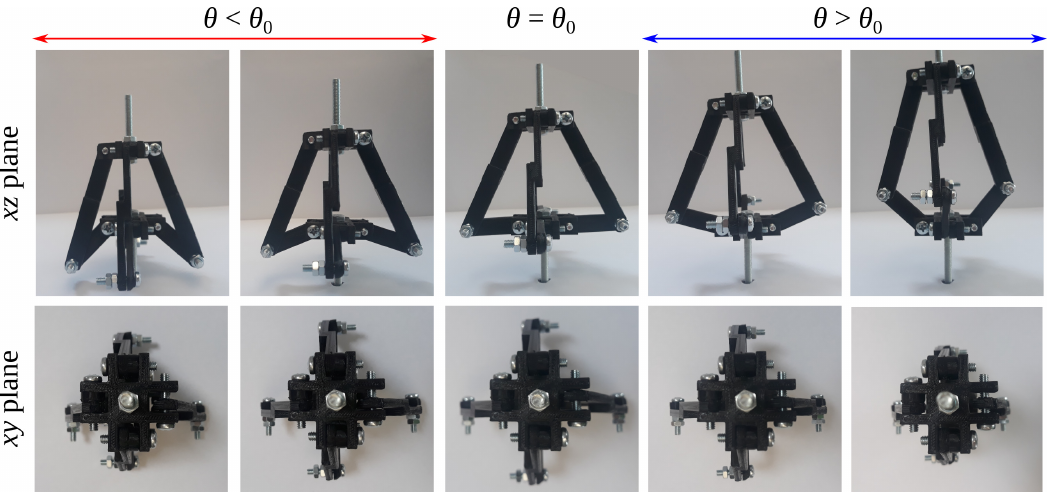
Figure 7. Deformation of the prototype corresponding to θ 0 = 64.62 ◦ presented from the perspective of the xz and xy